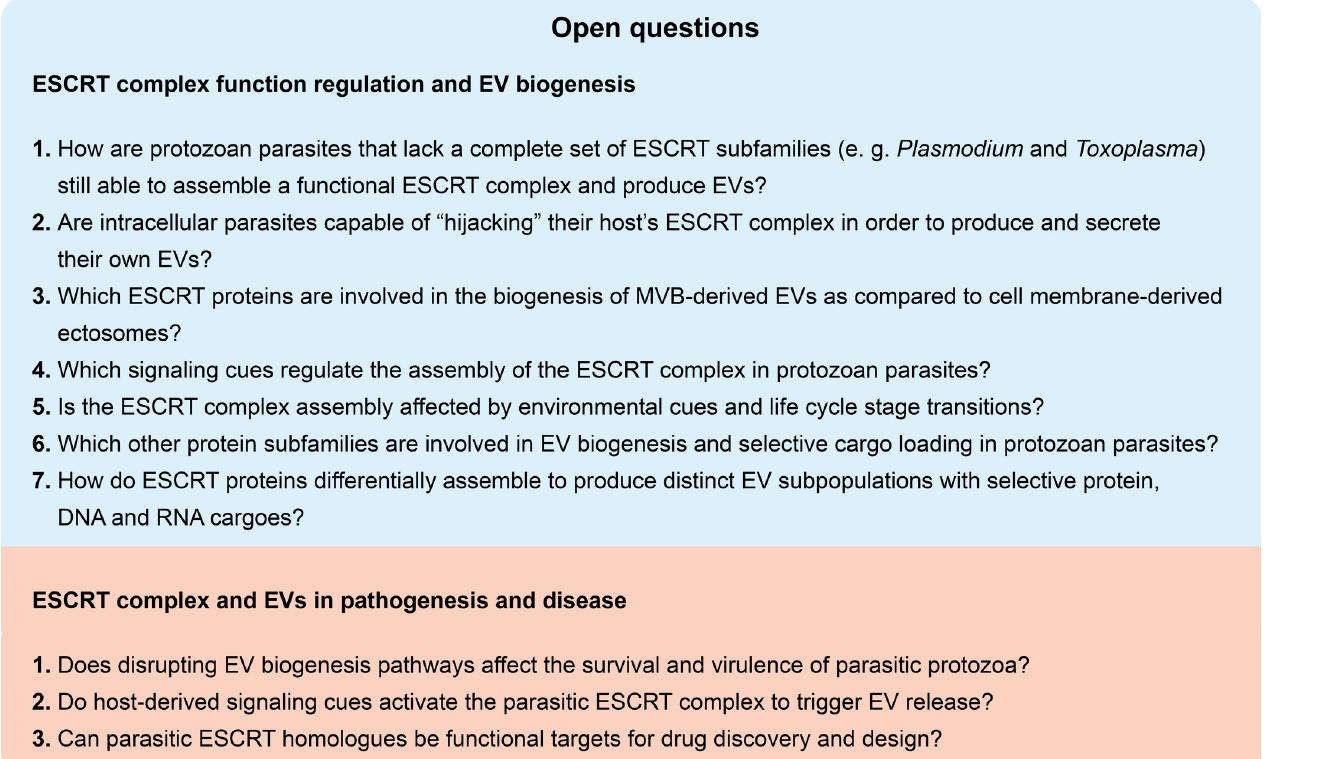
PLOS Pathogens| https://doi.org/10.1371/journal.ppat.1011140 February 23,